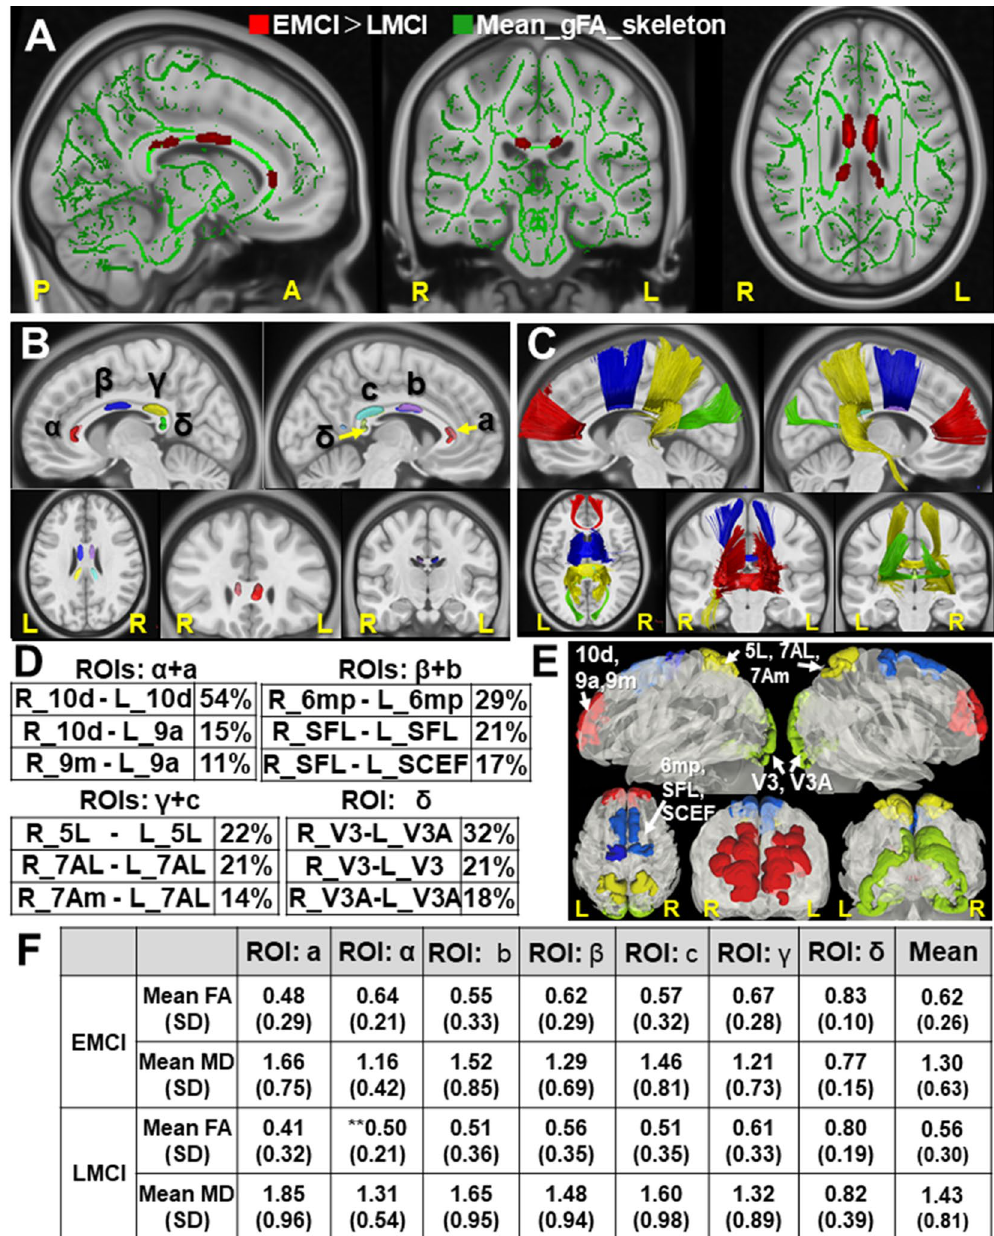
Figure 2. Sequential integration of TBSS and Tractography analyses. ( A ) The gFA (generalized fractional anisotropy)-based TBSS projects all subjects’ gFA data onto a mean gFA tract skeleton before applying voxelwise cross-subject statistics (EMCI vs. LMCI). The registered average subjects’ gFA tract skeleton is represented in green, while LMCI-related white matter changes were represented in red color. The mean gFA tract skeleton was overlaid on the sagittal, coronal, and axial T1-weighted MRI image (ICBM average brain). Left; sagittal view of the left hemisphere, Middle; coronal section, Right; axial view. Significance level was p < 0.05 (EMCI vs. LMCI, Threshold Free Cluster Enhancement and Family-Wise Error corrected). ( B ) The ROIs for fiber tracking, identified as white matter alterations by gFA-based TBSS (EMCI vs. LMCI), were shown overlaid on the sagittal, axial, and coronal T1-weighted MRI image (ICBM average brain), respectively. The α, β, γ, and δ indicate the ROIs in the Corpus Callosum of the left hemisphere, while the a, b, and c indicate those in the right hemisphere. ( C ) Tractogram, using the altered white matter regions as ROIs, was shown overlaid on the sagittal, axial, and coronal T1-weighted MRI image (ICBM average brain), respectively. The streamlines passing through the ROIs (α, a), ROIs (β, b), ROIs (γ, c), and ROI (δ), were shown in red, blue, yellow, and green, respectively. ( D ) The tables show the top 3 of cortical areas (%, number of streamlines/total of each tract) identified by endpoint analyses, into which the callosal fibers project inter- hemispherically. ( E ) Cortical areas used for TBSS-RSFC and TBSS-Graph method, overlaid on the 3D glass brain (HCP1065). The regions in red are cortical areas in the frontal lobe (i.e. 10d, 9a, 9m), those in blue are in the precentral region (i.e. 6mp, SFL, SCEF), those in yellow are in the parietal lobe (i.e. 5L, 7AL, 7Am), and those in green are in the occipital lobe (i.e. V3, V3A). ( F ) The table shows mean diffusion parameters (mean FA, MD) in each ROI of LMCI-related white matter changes, which were sub-classed into the ROI of α, a, β, b, γ, c, and δ. ** p < 0.05 (EMCI vs. LMCI, t -test). Statistical data are in Supplementary Fig. S3. FA fractional anisotropy, MD mean diffusivity, TBSS Tract-based spatial statistics, ML machine learning, MCI mild cognitive impairment, EMCI early